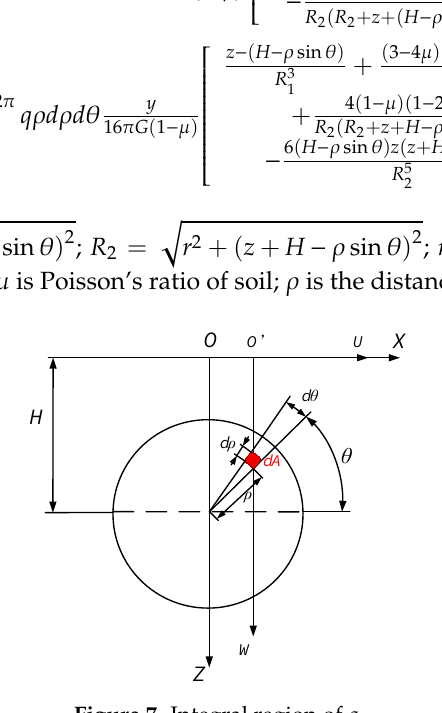
Figure 7. Integral region of q.